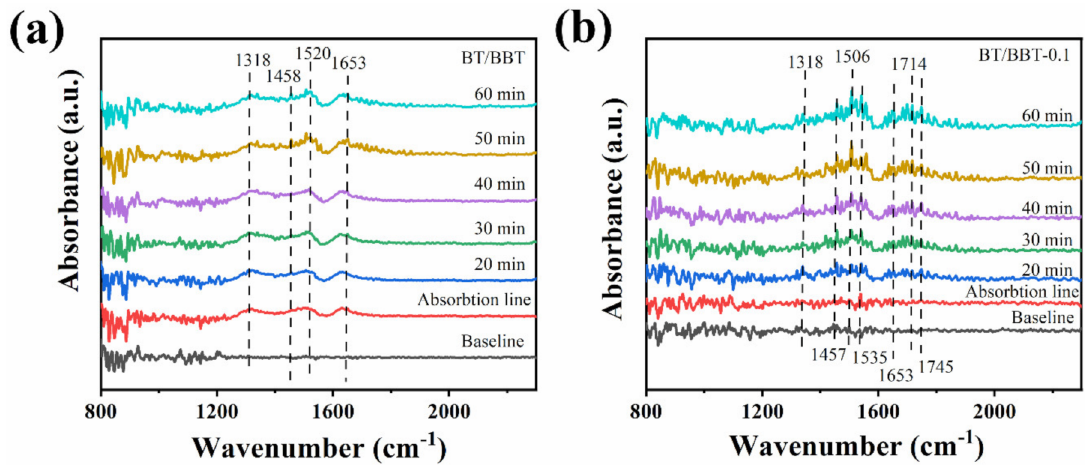
Figure 10. In situ DRIFT spectra of adsorption and photocatalytic on ( a ) BT/BBT and ( b )